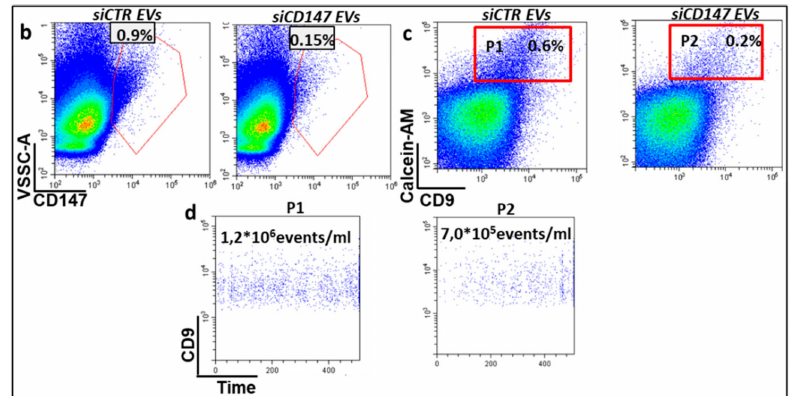
Figure 7. Nano-flow cytometry analysis of extracellular vesicles (EVs). ( a ) The amount of EVs released by colon cancer cells was assessed by Calcein-AM staining (1 µ M). To count the events (EVs), we maintained fixed the acquisition time (600 s for sample) thus demonstrating that CD147 downregulation (siCD147) induces a decrease in all fractions of EV although mostly in smaller ones; ( b ) Decrease of CD147-EVs in CD147 knockdown cells (siCD147 EVs); ( c ) EVs staining with CD9 and ( d ) counting to confirm the decrease of EVs released. The images are representative of three independent experiments. NM = EVs, non-stained small extracellular vesicles (sEVs) or medium extracellular vesicles (mEVs); siCTR sEVS = EVs, sEVs or mEVs released by HCT116 transfected with non-targeting control siRNA; siCD147 = EVs, sEVs or mEVs released by HCT116 transfected with specific anti-CD147 siRNA. P1 and P2 = gating strategy for EVs